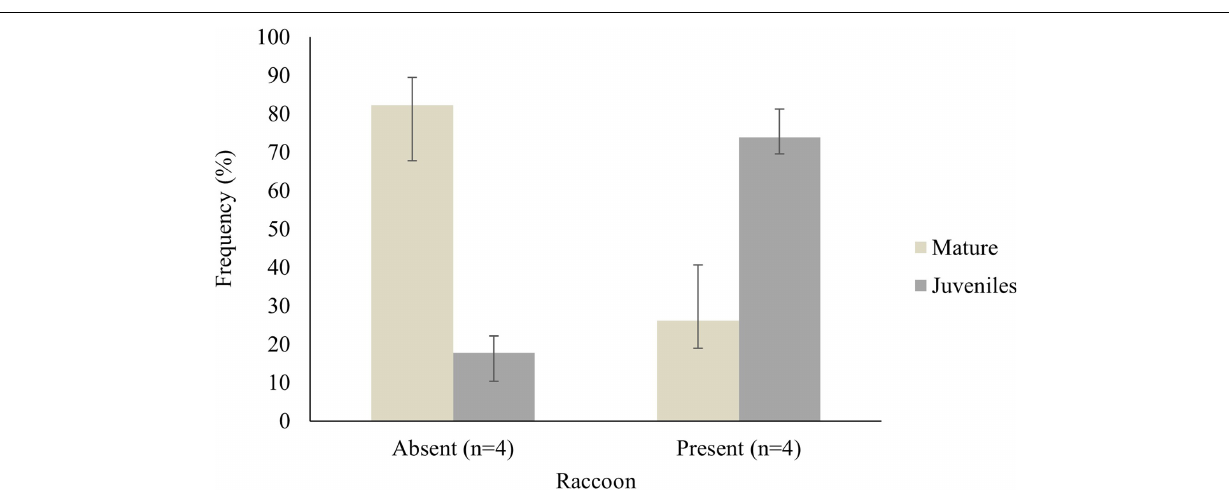
FIGURE 3 | Frequency of mature and juvenile crayfish in sites with or without raccoon in the Foreste Casentinesi, Monte Falterona, and Campigna National Park. The three sites sampled for the first time (Fosso Abetiolo, Fosso di Campo alla Sega, and Fiume d’Isola) were not considered in the graph. Bars represent medians + 1st and 3rd